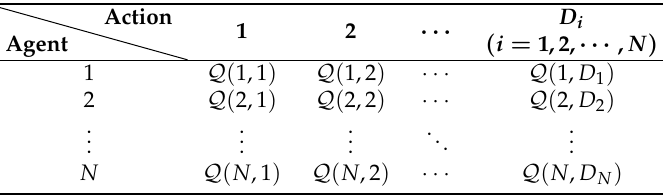
Table 1. Q -table used in the decentralized